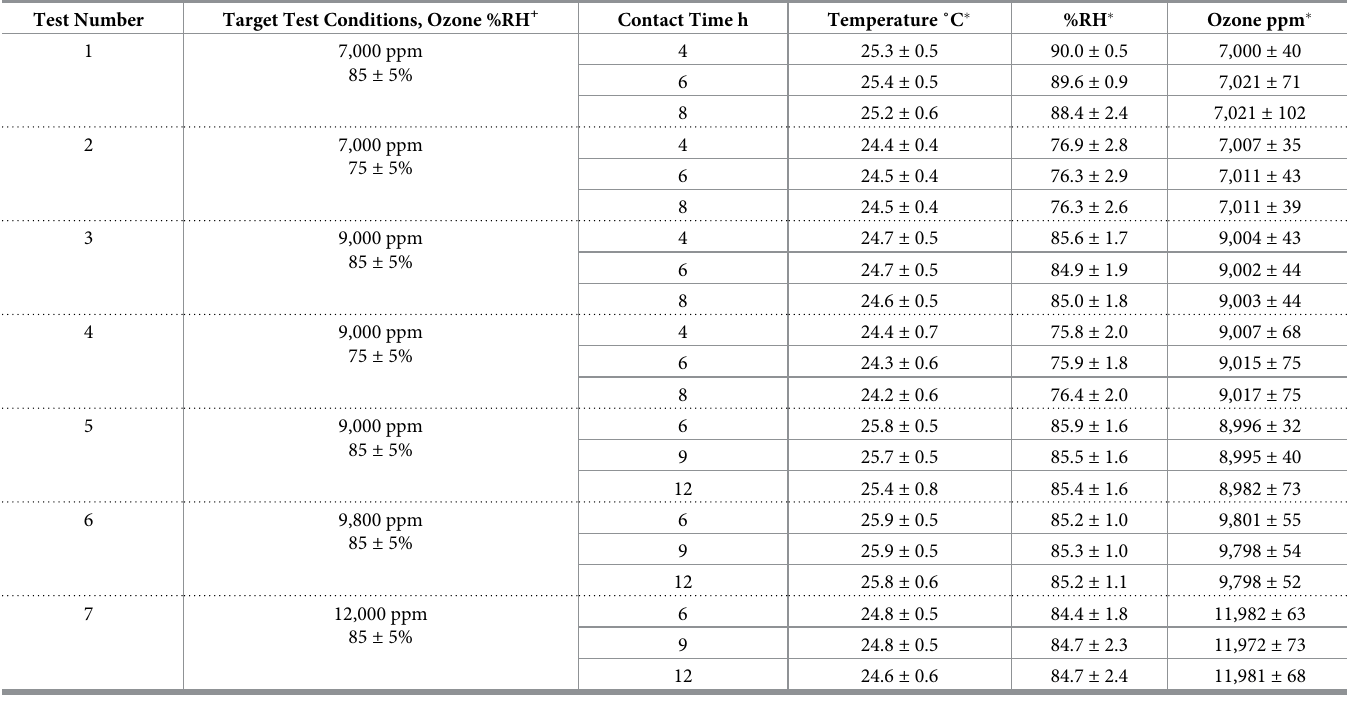
Table 3. Summary of actual temperature, relative humidity and ozone conditions for B . anthracis